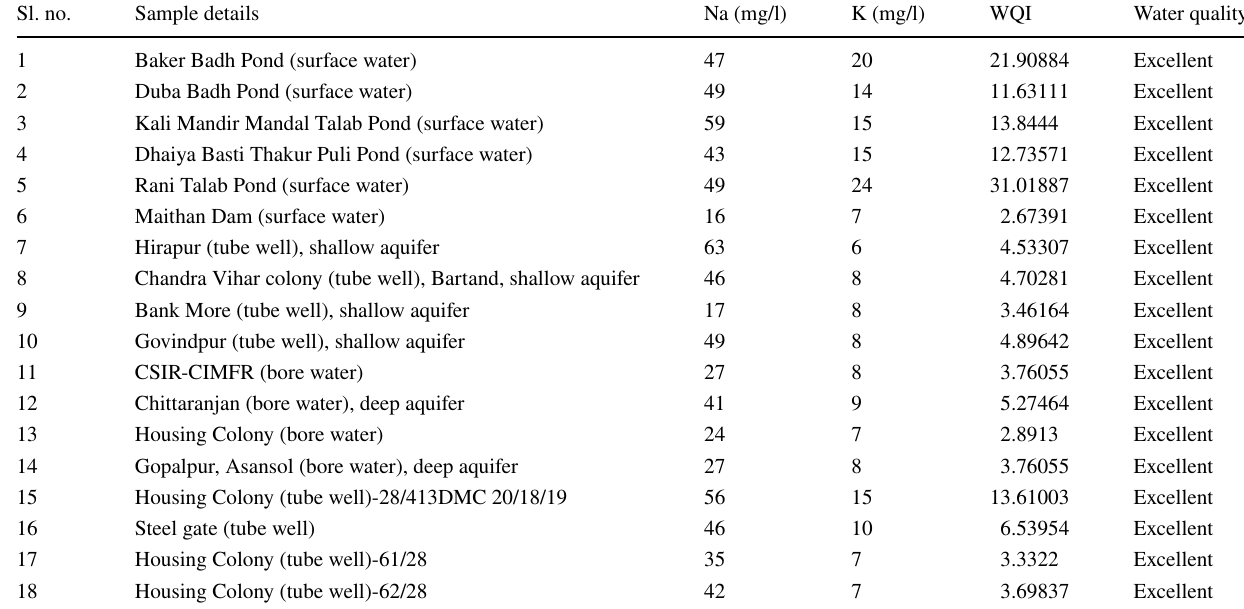
Table 4 Water quality classification based on WQI values of the study area Sl.